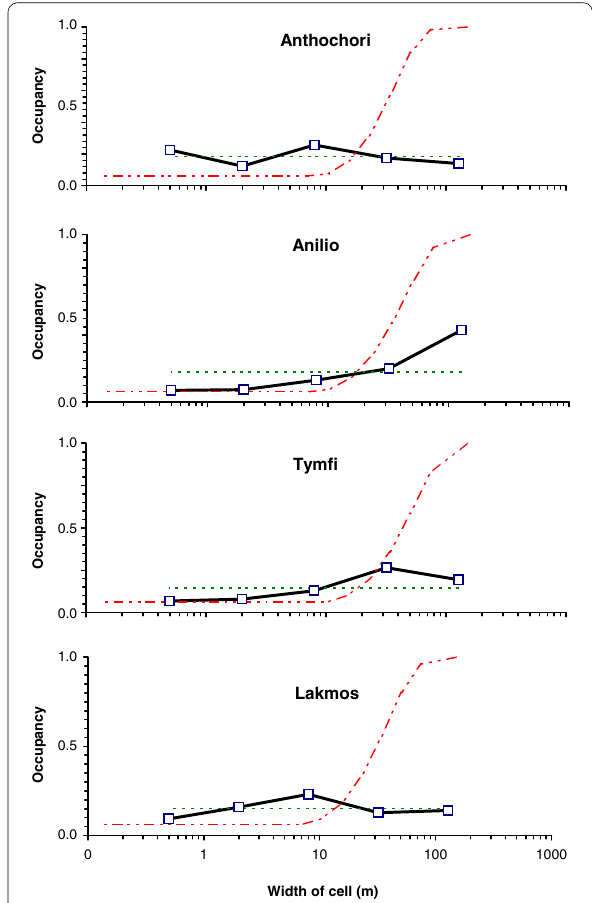
Fig. 1 Patterns of population density as a function of cell size. Occupancy is the average proportion of sub-cells occupied when a cell is subdivided into 16 smaller units. In each case the width refers to the sub-cell size, not the mother-cell size. For each population the solid curve is the outcome of 1000 simulations obtained by locating the grid in slightly different positions relative to the population. The black line is the average. The thin broken line is the occupancy of the equivalent fractal model while the rising broken curve is the occupancy of the equivalent Poisson distribution